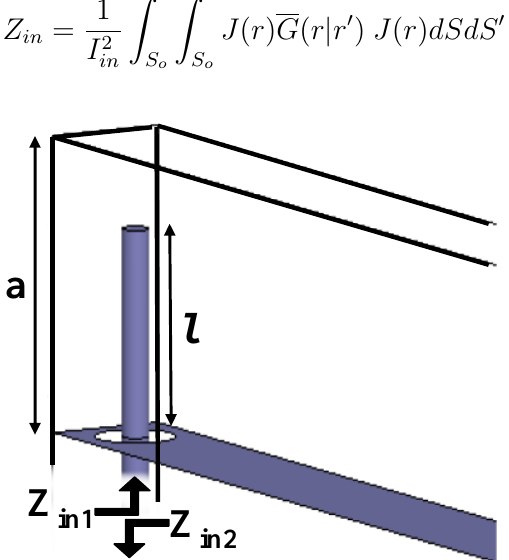
Figure 9. Definition of the input probe